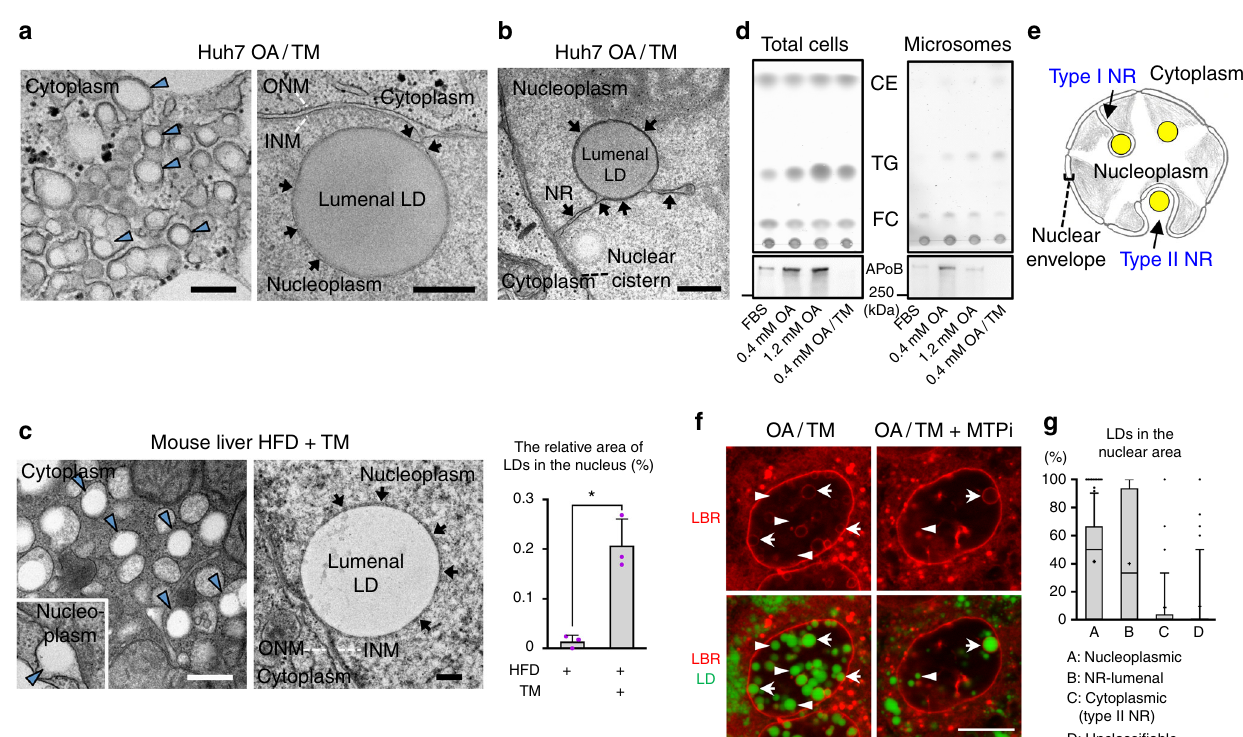
Fig. 2 LDs are present in the lumen of the type I NR. a Huh7 treated with OA/TM for 24 – 48 h harbored LDs in the lumen of the ER (left; arrowheads) and within the type I NR (right; arrows mark the NR). INM: inner nuclear membrane, ONM: outer nuclear membrane. Bars, 0.2 μ m. b Huh7-expressing HRP- KDEL treated with OA/TM for 24 h. DAB precipitated in the type I NR lumen (arrows). Bar, 0.5 μ m. c Mouse hepatocytes in vivo after high-fat diet feeding for 6 weeks and TM injection. Lumenal LDs were observed in the ER (arrowheads), the nuclear cistern (arrowhead in the inset) (left fi gure; Bar, 0.5 μ m), and in the type I NR (arrows mark the NR) (right fi gure; Bar, 0.2 μ m). They contained more nuclear LDs than the control fed the high-fat diet and injected with vehicle alone. Mean ± SD of three independent experiments. * p < 0.01, Student ’ s t test. d Microsomes of Huh7 treated with none, 0.4 m M OA, 1.2 m M OA, or OA/TM for 48 h. The OA/TM-treated cell microsome contained triglycerides (TG) and cholesterol esters (CE) most abundantly (by thin layer chromatography), but showed the lowest amount of ApoB (by Western blotting). e Three different kinds of LDs in the nuclear area: Nucleoplasmic LDs (A) , NR-lumenal LDs (within the type I NR) (B) , and cytoplasmic LDs (within the type II NR) (C). f Nucleoplasmic LDs (arrowheads) and NR-lumenal LDs (arrows) are distinguished by whether they are outside of or within LBR rings, respectively. Huh7 treated with OA/TM for 48 h. Both LDs were reduced by MTPi (100 n M BAY 13-9952). Bar, 10 μ m. See also Supplementary Fig. 2e. g The number of nucleoplasmic LDs, NR-lumenal LDs, and cytoplasmic LDs within the type II NR were counted in randomly taken electron micrographs of Huh7 treated with OA/TM for 48 – 72 h. Box plot of pooled data from three independent experiments. The average is shown by + . Number of nuclei examined = 128. Source data are provided as a Source data fi